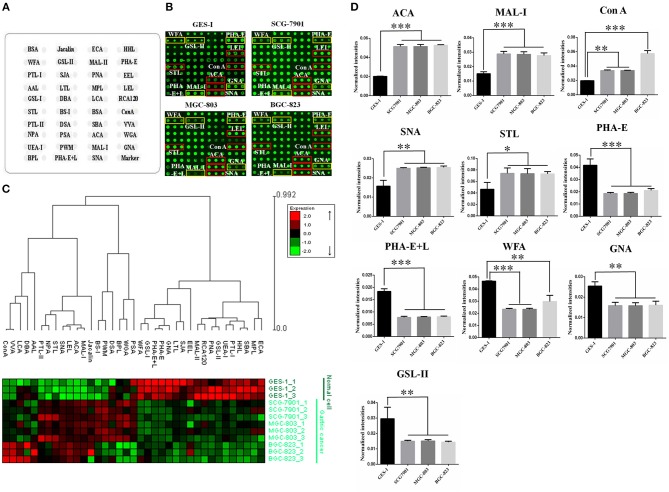
Evaluation of altered glycopatterns in GC cell lines using lectin microarrays. (A) The layout of lectin microarray. A total of 37 lectins were dissolved in the recommended buffer and spotted on lectin microarray. (B) Scanned images were obtained for the analysis of GES-1 and GC cell lines. The lectins with increased NFIs in GC cell lines are marked with red boxes, and those with decreased NFIs are marked with yellow boxes. (C) Heat map and hierarchical clustering analysis of the 37 lectins with three biological replicates. Glycan profiles of GC cell lines (SGC-7901, MGC-803, and BGC-823) and their normal reference (GES-1) were clustered (average linkage, correlation similarity). Samples are listed in rows and the lectins are listed in columns. The color and intensity of each square indicated expression levels relative to other data in the row. Red, high; green, low; black, medium. (D) The NFIs of 10 lectins were significantly altered in GC cells compared to the normal reference based on fold change and t-test (*p < 0.05, **p < 0.01, and ***p < 0.001). The data are presented as the averaged NFI ± SD of three biological replicates.